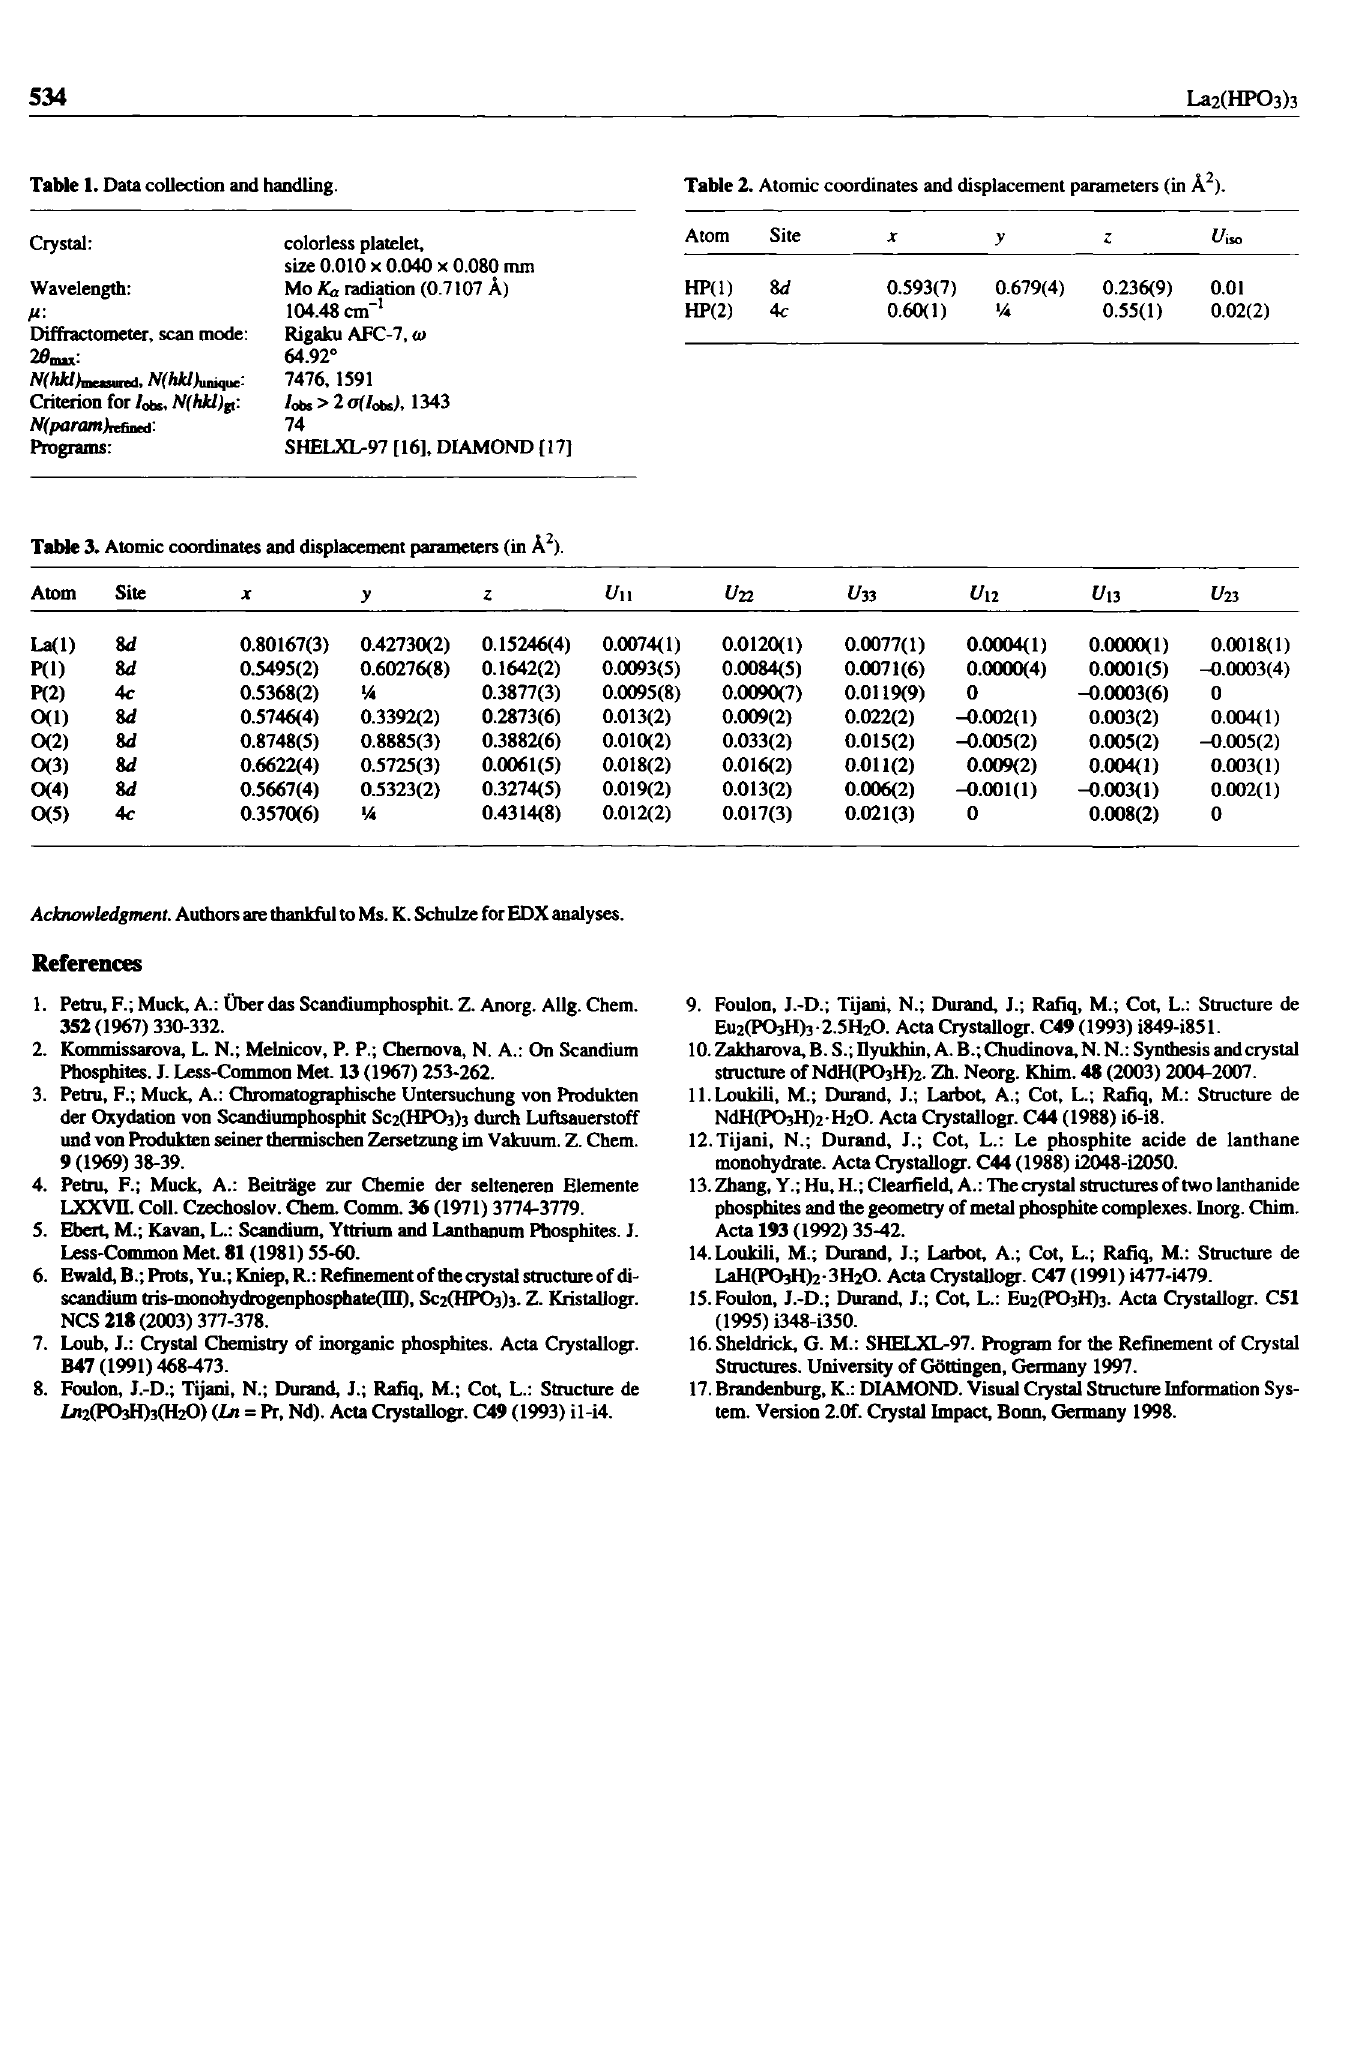
Table I. Data collection and handling. Table 2. Atomic coordinates and displacement parameters (in Ä 2 ).